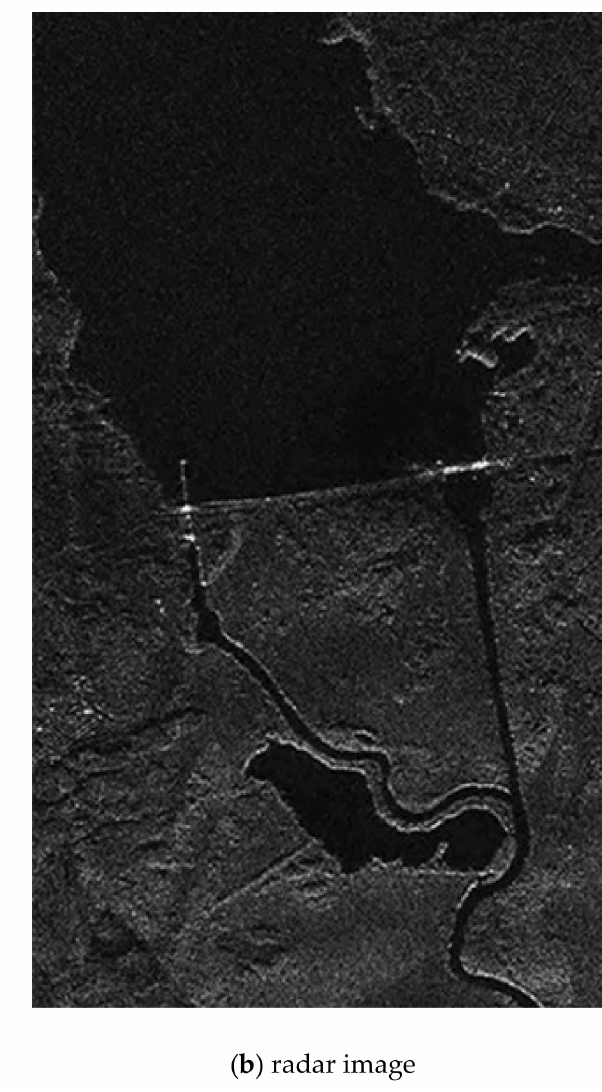
Figure 11. Heterogeneous images of the